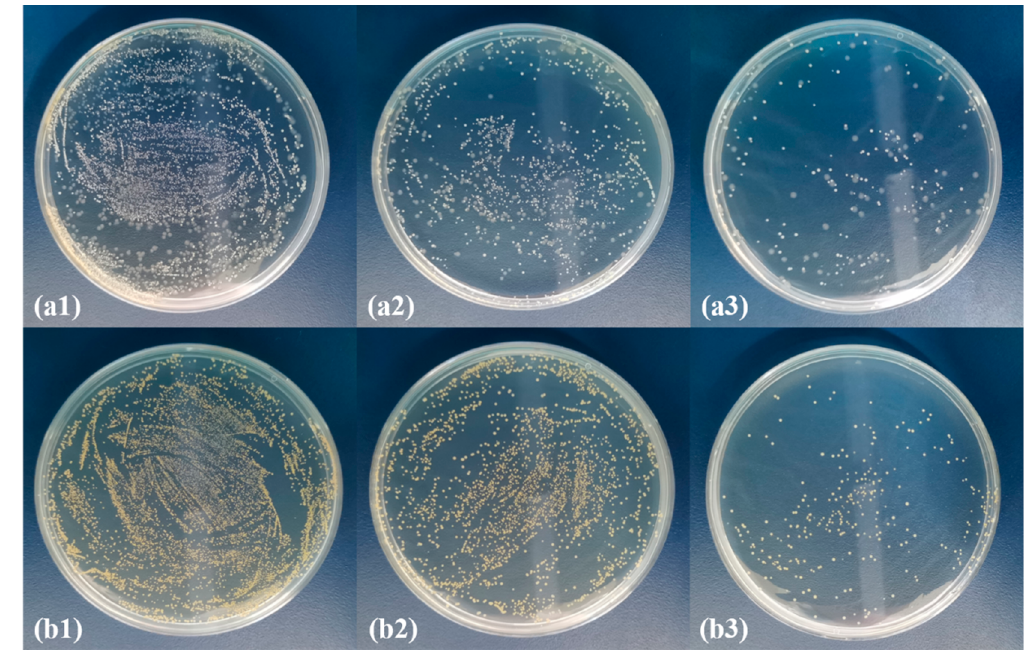
Figure 8. Antibacterial effect against ( a1 – a3 ) Escherichia coli and ( b1 – b3 ) Staphylococcus aureus of ( a1 , b1 ) the control group, ( a2 , b2 ) ZIF-8@ melt-blown nonwoven fabrics, and ( a3 , b3 ) Ag@ZIF-8@ melt-blown nonwoven fabrics.